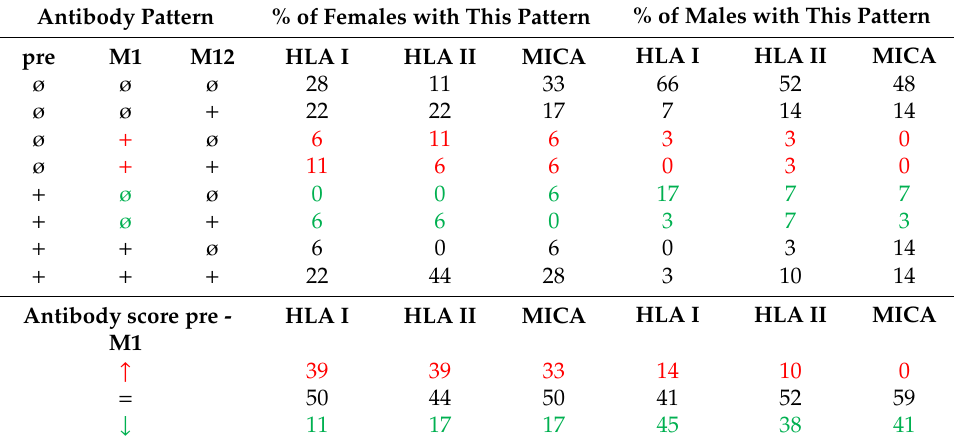
Table 3. Individual courses of HLA / MICA antibodies in 18 female and 29 male kidney transplant recipients pre and at month 1 (M1) and month 12 (M12) after vaccination with Prevenar. Antibody Pattern % of Females with This Pattern % of Males with This Pattern pre M1 M12 HLA I